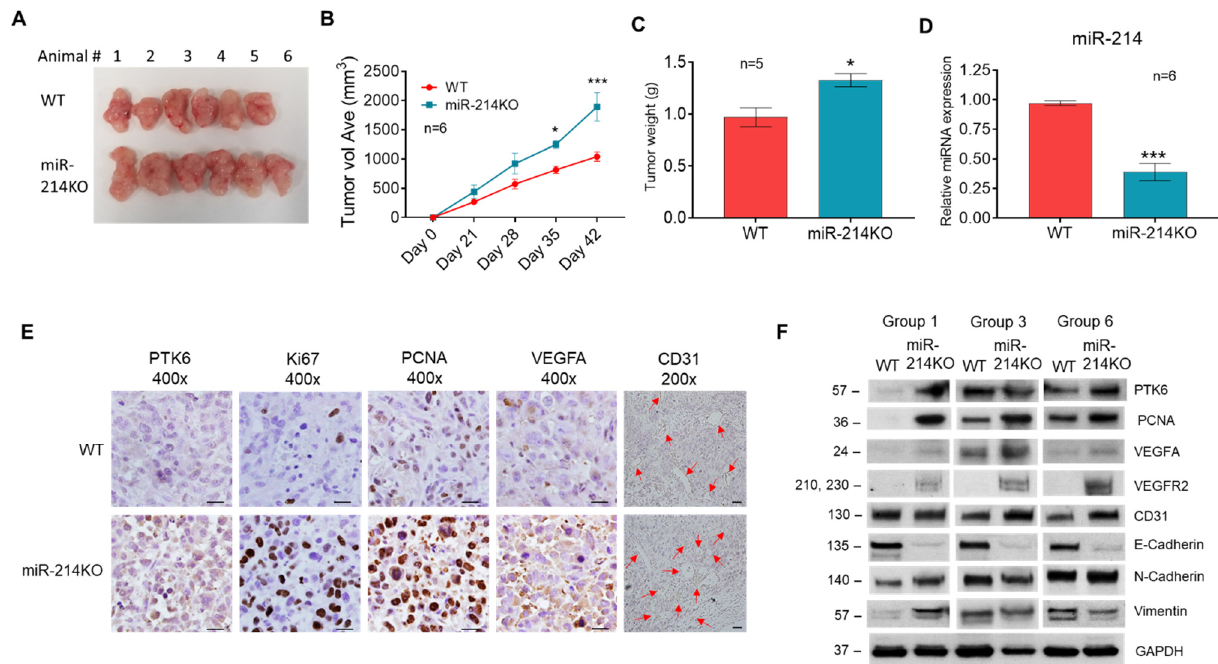
Figure 6. The effects of miR-214 on tumor growth, angiogenesis, and EMT in tumor xenografts. WT or miR-214KO PC3 cells were injected in nude male mice to form xenograft tumors. ( A ) Representative images of xenograft tumors at day 42 after injection. ( B ) Tumor volume in nude mice subcutaneously injected with miR-214 WT or KO PC3 cells. Data are presented as means ± SEM of the tumor volumes, calculated with the formula, V = length × width 2 /2. n = 6, * p < 0.05, *** p < 0.0005 by two-way ANOVA with Šídák’s multiple comparisons test between WT and KO groups. ( C ) Tumor growth of nude mice. ( D ) Quantification of expression of miR-214 by qRT-PCR as a percentage of U44 expression in micro-dissected xenograft prostate cancer cells. N = 6, *** p < 0.0005 ( E ) Representative IHC staining of hematoxylin and eosin, Ki67, PCNA, VEGFA, PTK6, and CD31 staining in xenograft prostate tumor tissues. Original magnification, ×400 (PTK6, Ki67, PCNA, VEGFA) and ×200 (CD31, red arrows = blood vessels). ( F ) Western blot expression of proliferative, angiogenesis, and EMT markers in PC3 WT and miR-214KO xenograft tumors. GAPDH was used as the loading control. Original blots see Supplementary File S6.